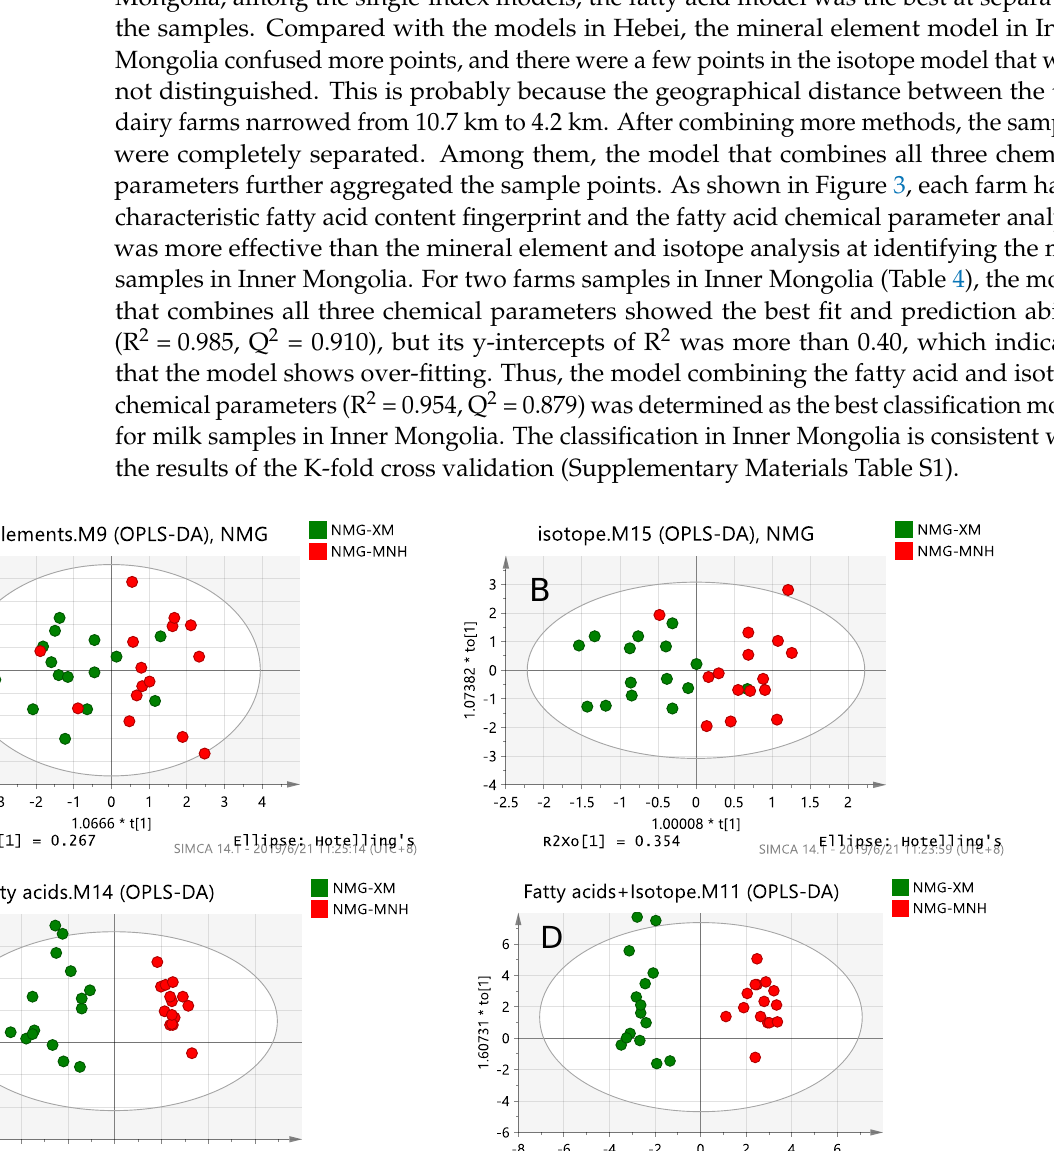
Isotopes; ( C ) Fatty acids; ( D ) Fatty acids combined with isotopes.